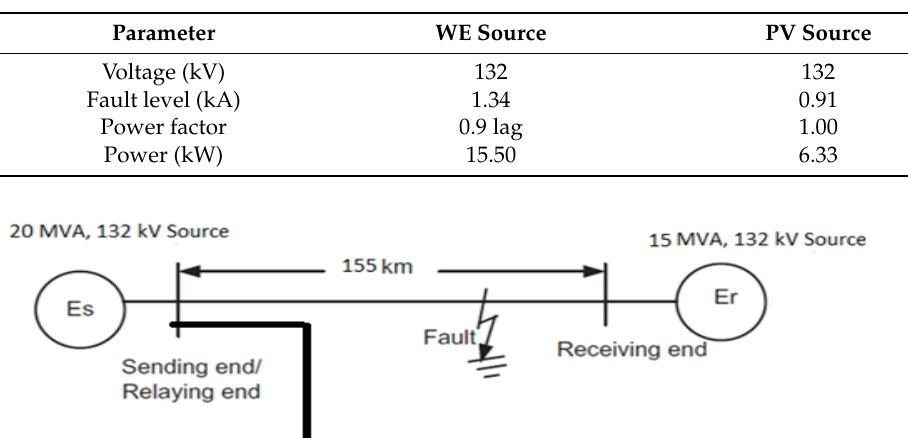
Table 14. RES parameters.